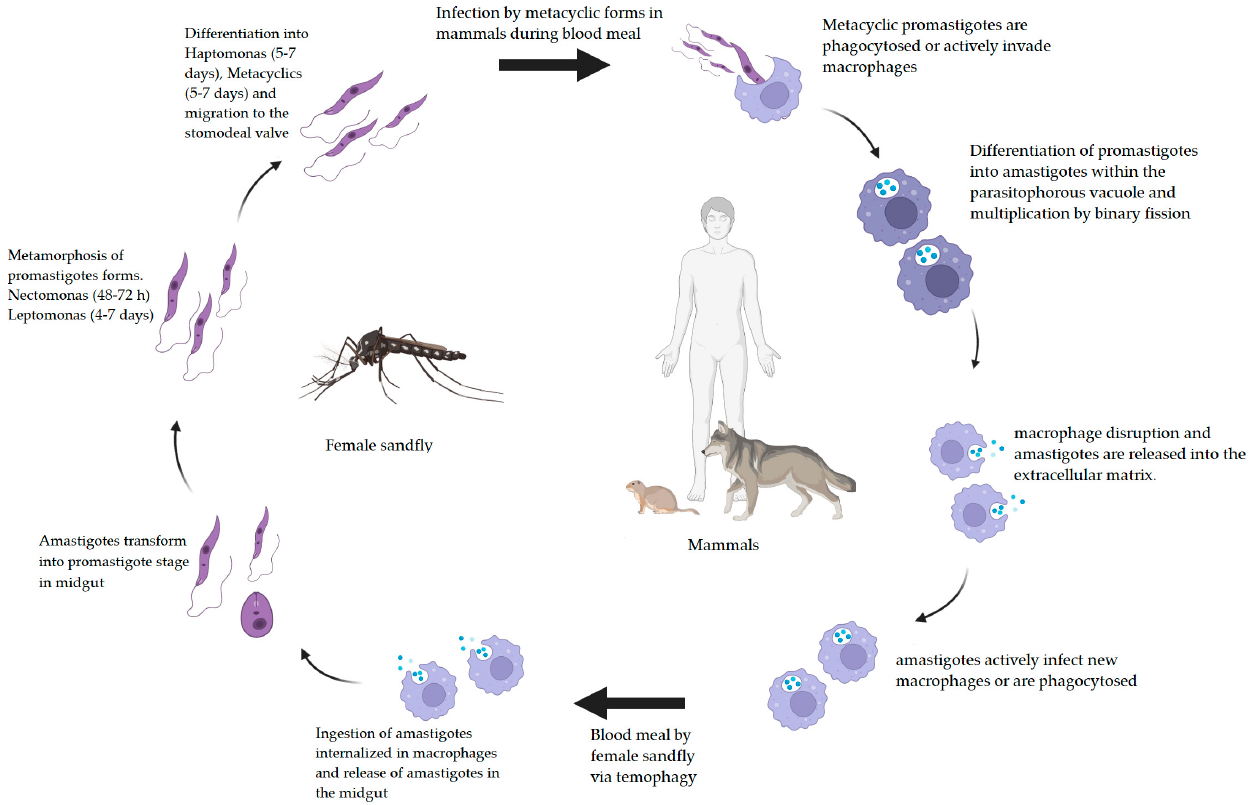
Figure 1. Digenetic life cycle of Leishmania infantum , alternating between mammalian and female sand fl y hosts.